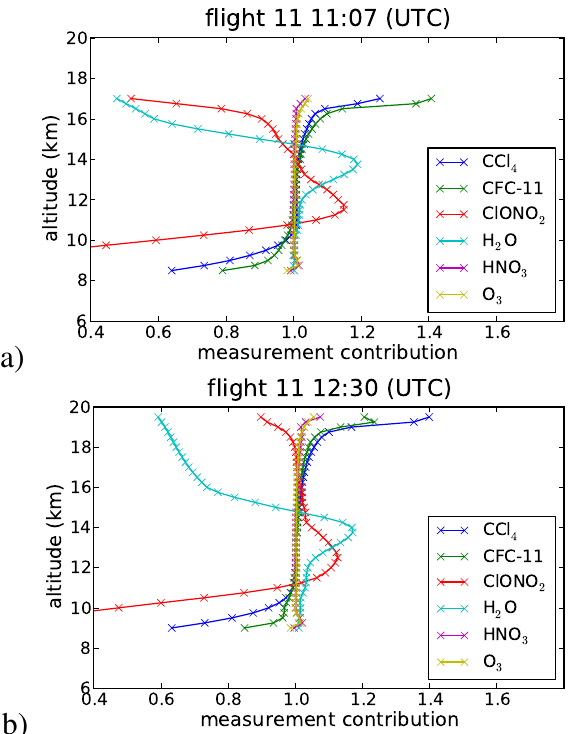
Fig. 8. Vertical resolution for CCl Fig. 7. Measurement contribution (sum of rows of averaging kernel Fig. 7. Measurement contribution (sum of rows of averaging kernel matrix) for CCl matrix) for CCl 4 and CFC-11, ClONO 2 , H 2 O, HNO 3 and O 3 for 11:07 (UTC) in panel (a) and 12:30 in panel (b) . ClONO O , HNO , H , and O for profiles at 11:07 (UTC) in panel (a) and 12:30 in panel (b) . profiles at 11:07 in (a) and 12:30UTC in (b) . 2 2 3 3